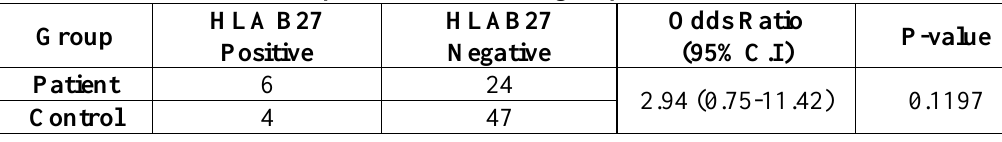
Table (2): HLAB27 in both patient and control